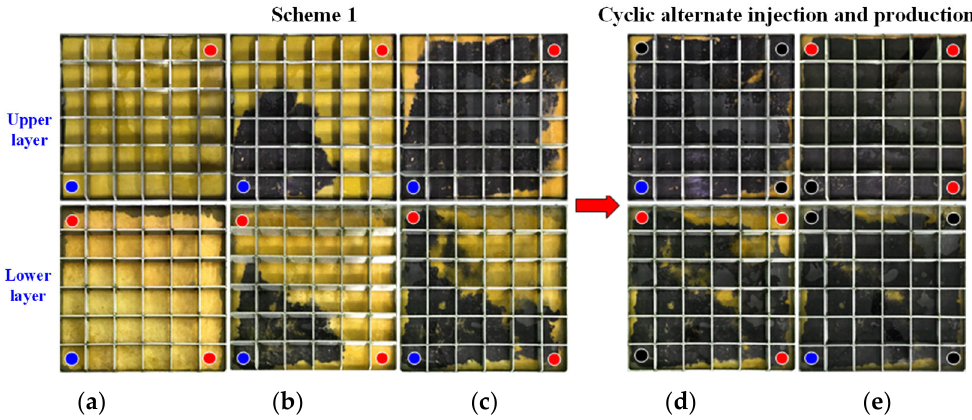
Figure 8. Sweeping field diagram of Experimental Program 3; ( a ) images of the upper and lower layers at hour 0; ( b ) images of the upper and lower layers at hour 6; ( c ) images of the upper and lower layers at hour 12; ( d ) images of the upper and lower layers at hour 15; ( e ) images of the upper and lower layers at hour 18.